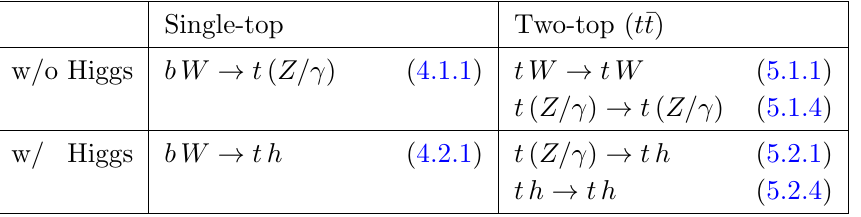
paper, labelled according to the section in which each category is discussed.